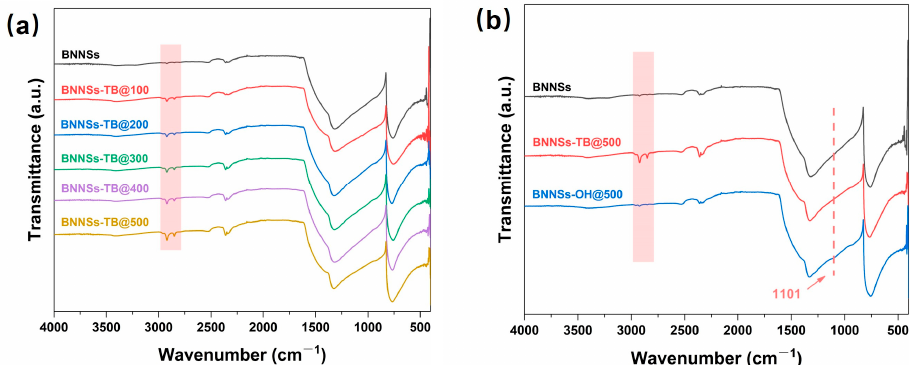
Figure 1. ( a ) FT-IR spectra of BNNSs-TB with di ff erent doses. ( b ) FT-IR spectra of BNNSs, BNNSs-